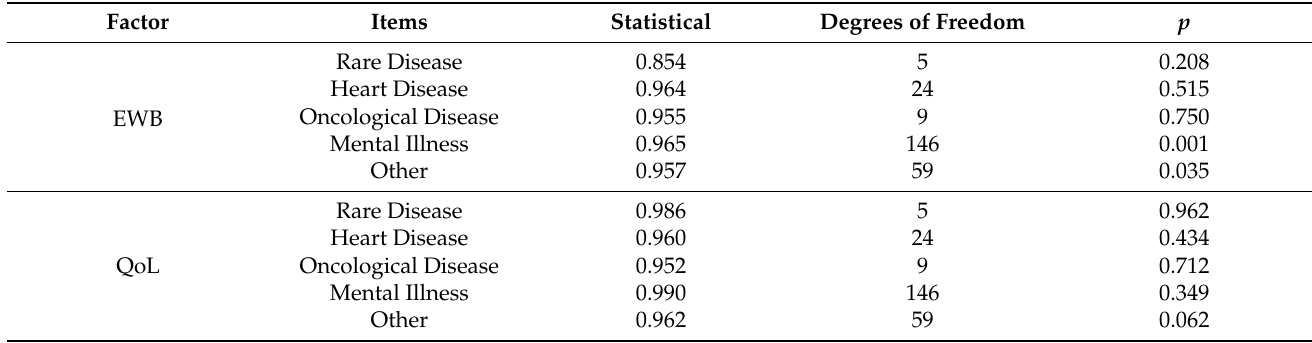
Table 2. Normality test.